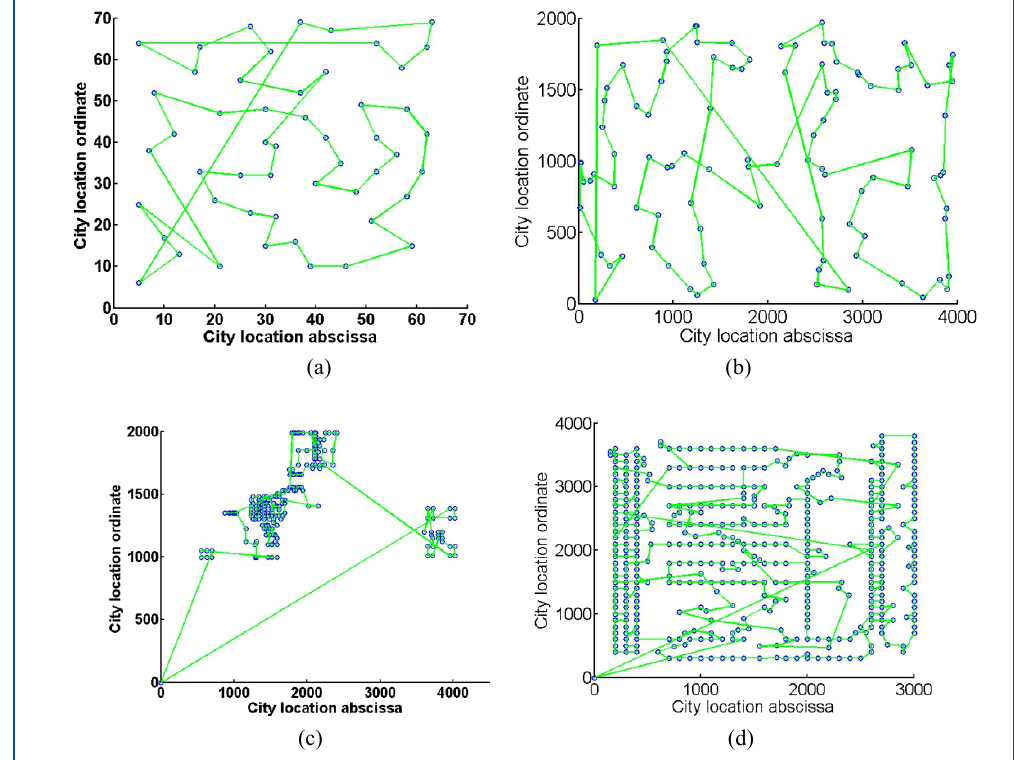
Figure 3. Denotes the optimal route of eil51 (a), kroA100 (b), d198 (c) and pcb442 (d)